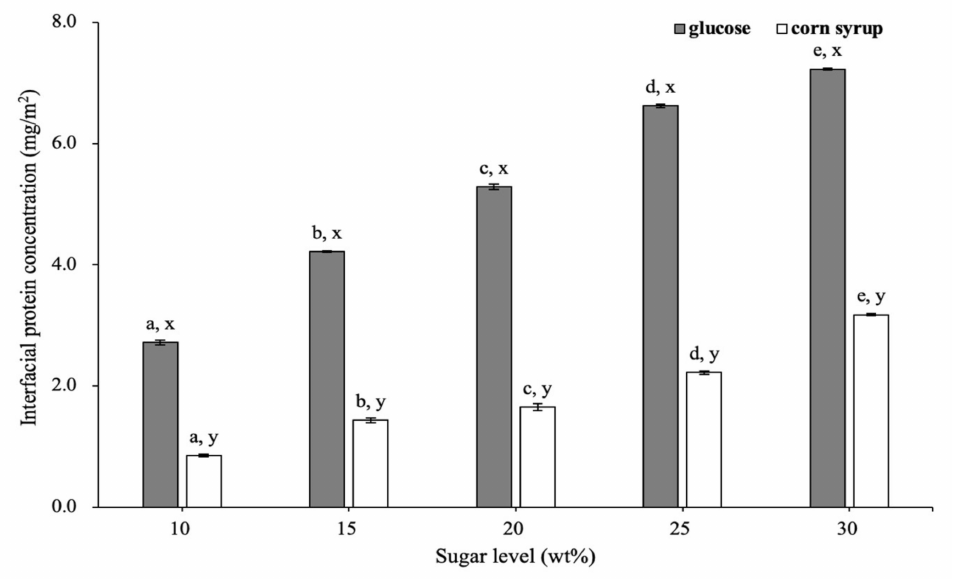
Figure 6. Interfacial protein concentration of whipped creams at different sugar concentrations. Different letters of a–e on the top of columns represent significant differences ( p < 0.05) among various sugar levels. Different letters of x, y on the top of columns represent significant difference ( p < 0.05) between glucose and corn syrup in the same concentration.